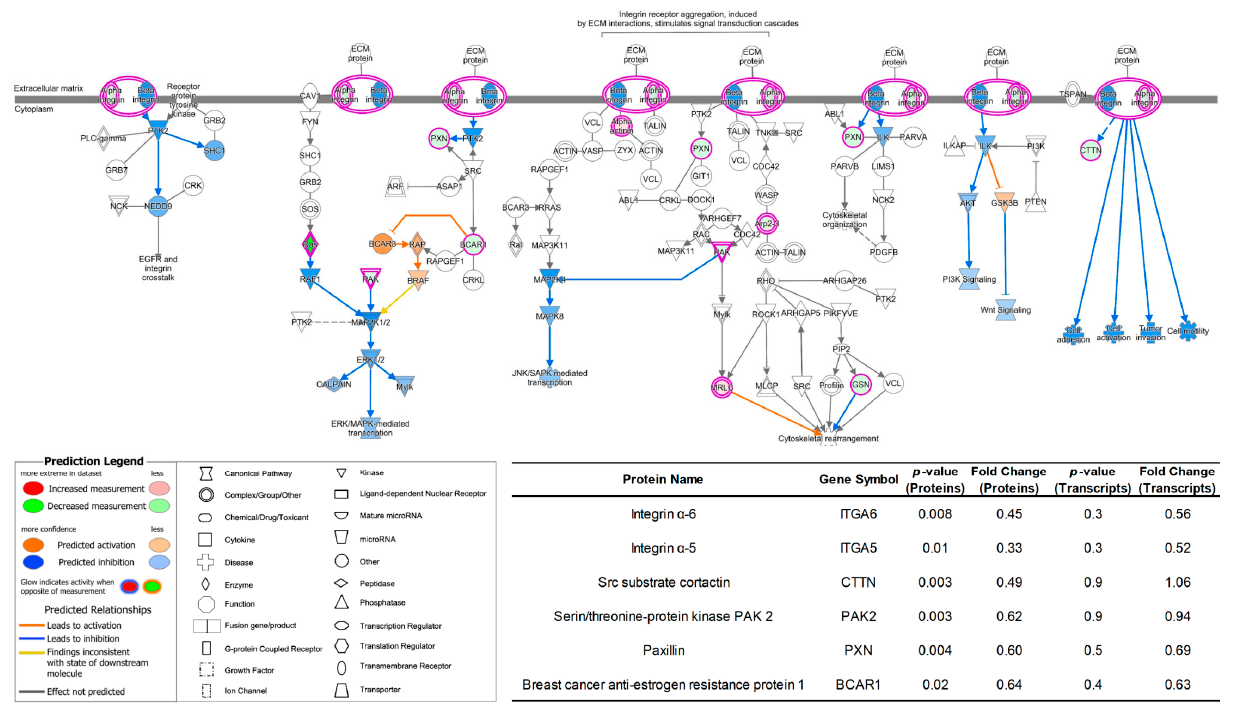
Figure 5. Inhibited integrin signaling pathway of protein expressions in 231BR cell line cultivated by Plasmax in comparison with DMEM. Color codes and symbols are the same as Figure 2. The inset table provides the p -values and fold-change numbers of proteins and their corresponding transcripts that are involved in this pathway.